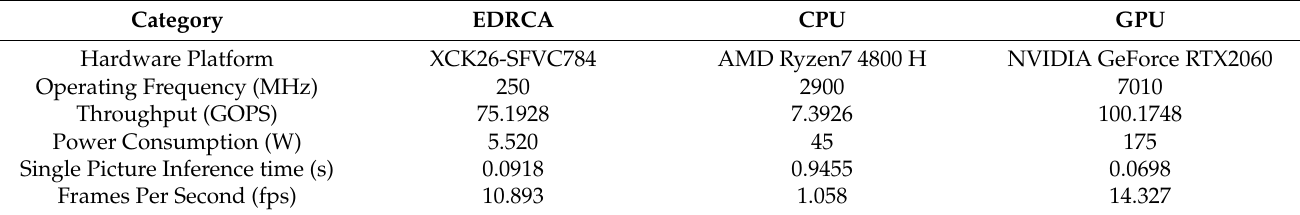
Figure 8. Comparison of original graph and predicted results on Xilinx KV260 FPGA, AMD Ryzen7 CPU, and NVIDIA GeForce RTX2060; ( a ) Original image; ( b ) Xilinx KV260 FPGA Predicted results; ( c ) AMD Ryzen7 CPU Predicted results; ( d ) NVIDIA GeForce RTX2060 Predicted results. Table 3. Performance comparison results of different platforms.